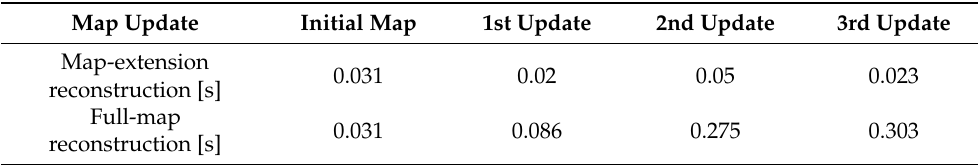
Table 5. Time consumption of roadmap reconstruction.